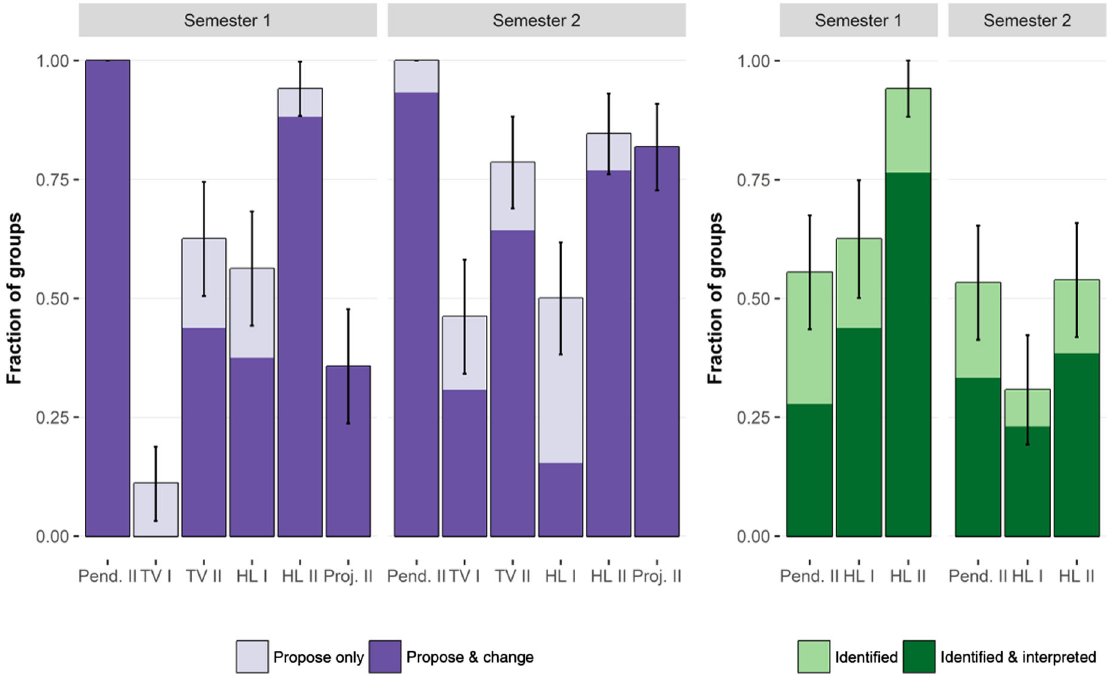
FIG. 1. The fraction of groups in semesters 1 and 2 proposing and carrying out changes to their experiments (left, purple) and identifying and interpreting model disagreements (right, green) in their lab notes indicates that students extensively engage in these behaviors, with variation across activities and semesters. Lab activities (indicated on the x axis) are ordered sequentially and correspond to weeks listed in Table